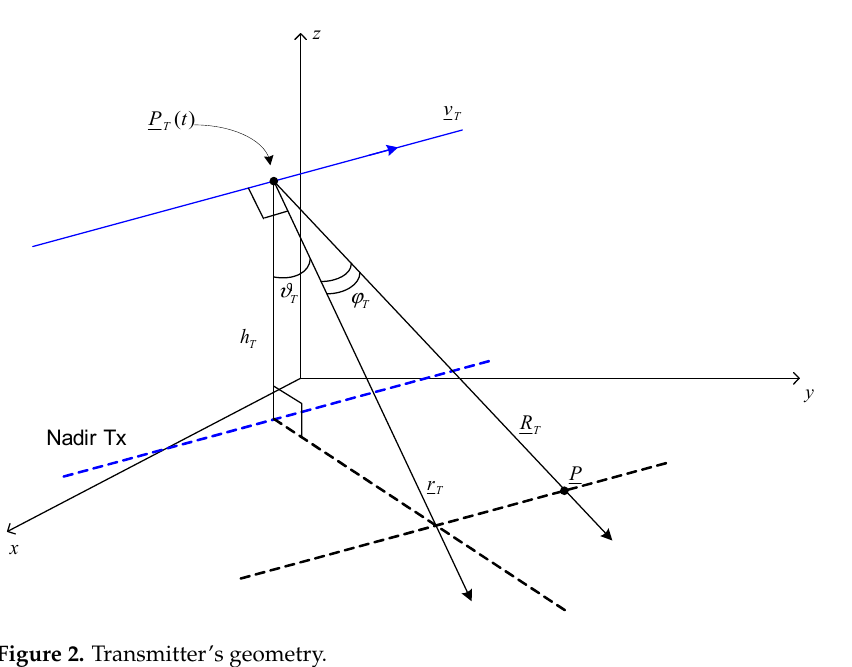
Figure 2. Transmitter’s geometry.